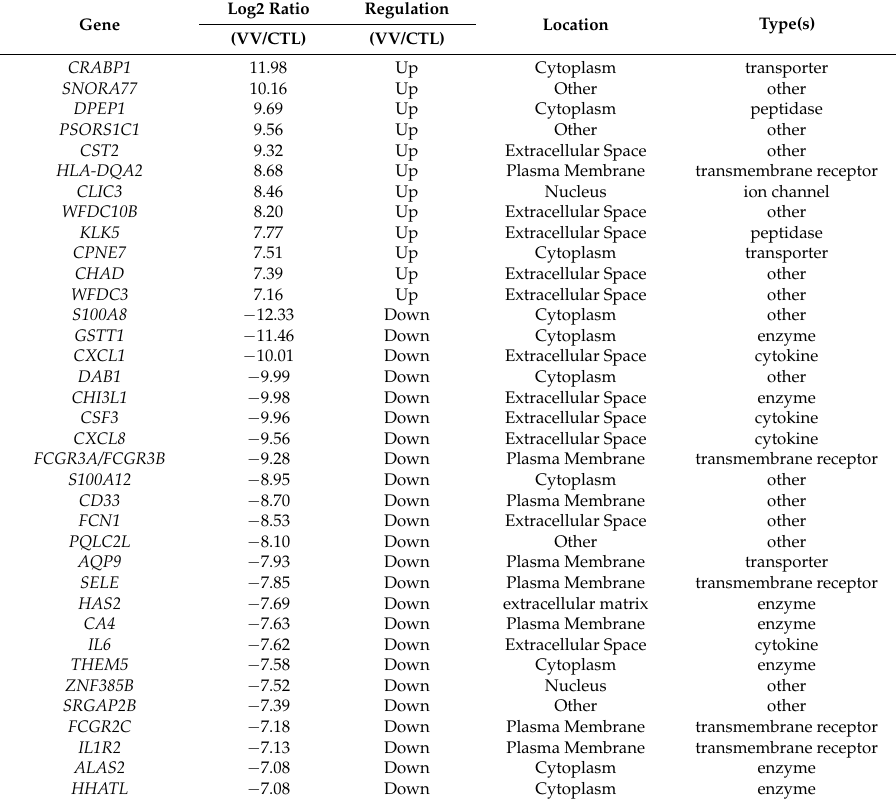
Table 2. Highly differentially expressed gene list between venous samples from control (CTL) patients and patients with varicose veins